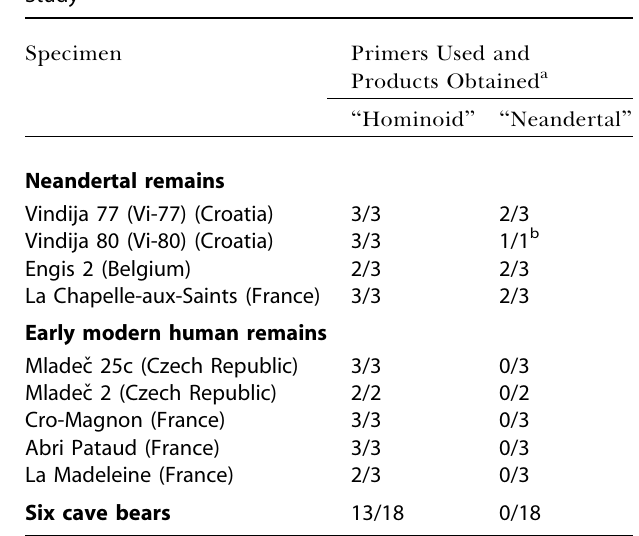
Table 1. DNA Retrieved from Late Pleistocene Fossils in